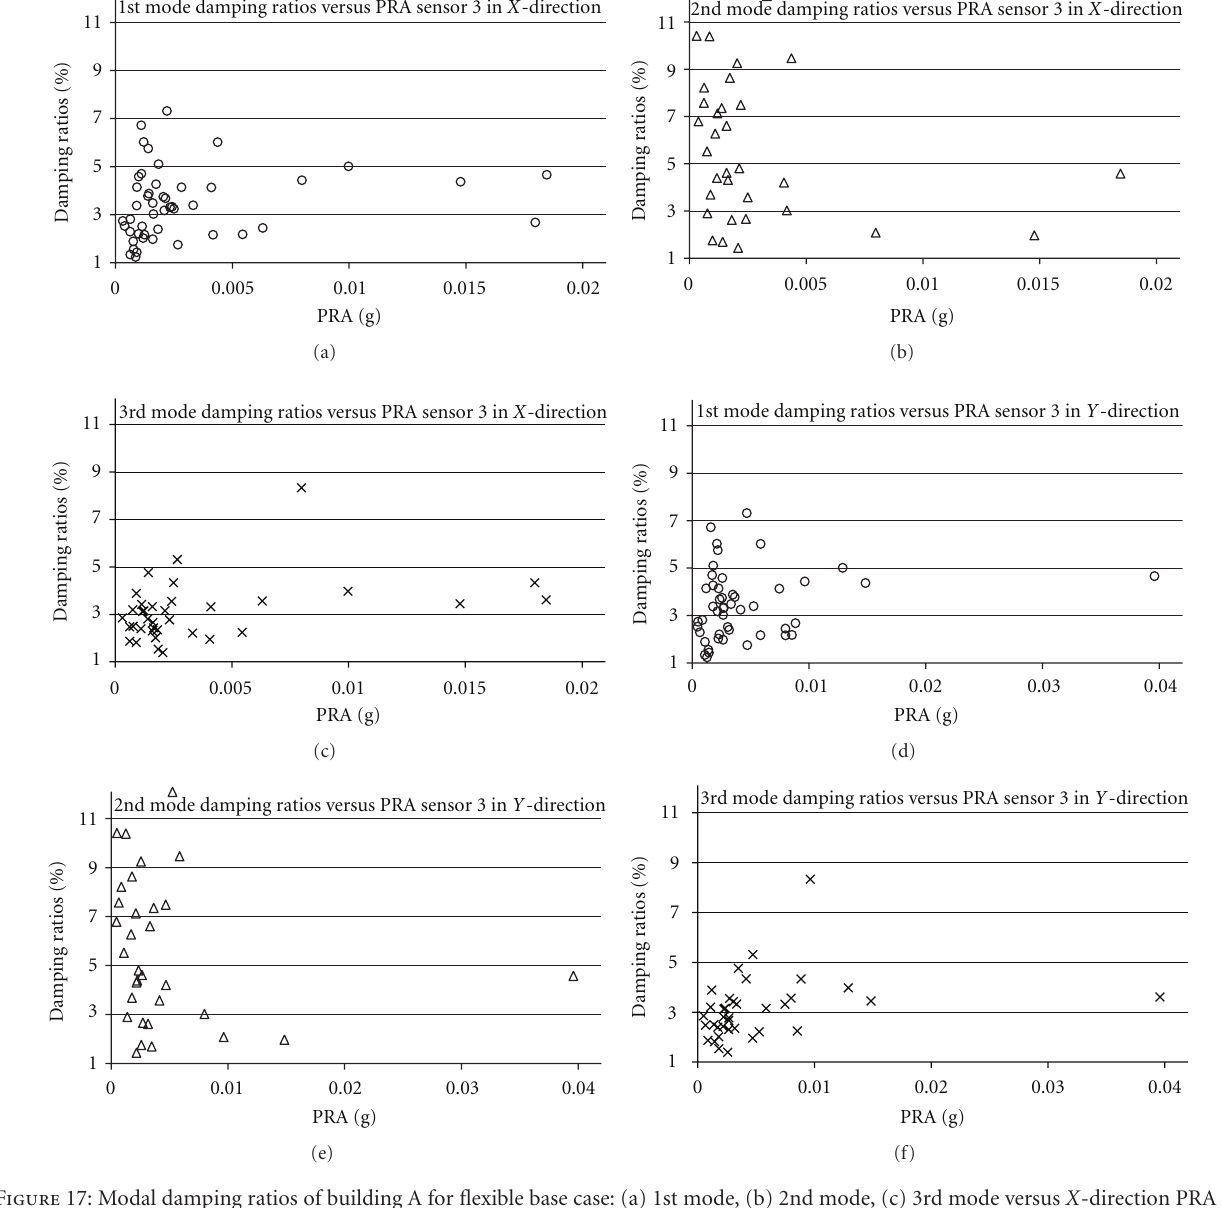
Figure 17: Modal damping ratios of building A for flexible base case: (a) 1st mode, (b) 2nd mode, (c) 3rd mode versus X -direction PRA of sensor 3; (d) 1st mode, (e) 2nd mode, and (f) 3rd mode versus Y -direction PRA of sensor